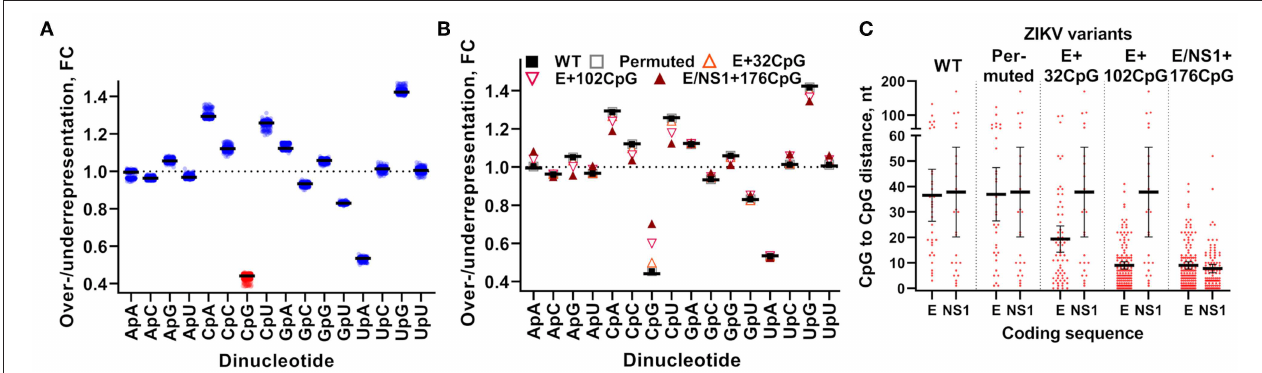
FIGURE 2 | Dinucleotide composition in ZIKV variants. CpG dinucleotide suppression in (A) complete wild-type ZIKV genomes ( n = 773) retrieved from GenBank on 1.10.2019 and (B) CpG-recoded ZIKV variants. Over- or underrepresentation (fold change, FC) was calculated for each dinucleotide: observed prevalence [p observed (CpG)] was divided by estimated frequency [p estimated (CpG)] based on mononucleotides occurrence across the whole genome—e.g., p estimated (CpG) = p(C) × p(G). Solid lines represent mean. Dotted lines represent expected level of dinucleotide representation. (C) The density of CpG dinucleotides within ZIKV E and NS1 coding regions. Y-axis represents a number of nucleotides in between two neighboring CpGs. Solid lines and whiskers represent mean and 95% confidence intervals.